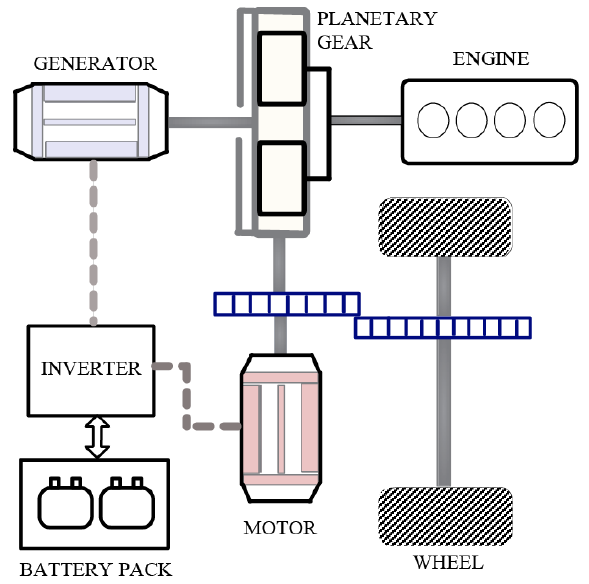
Figure 1. Powertrain configuration of hybrid electric